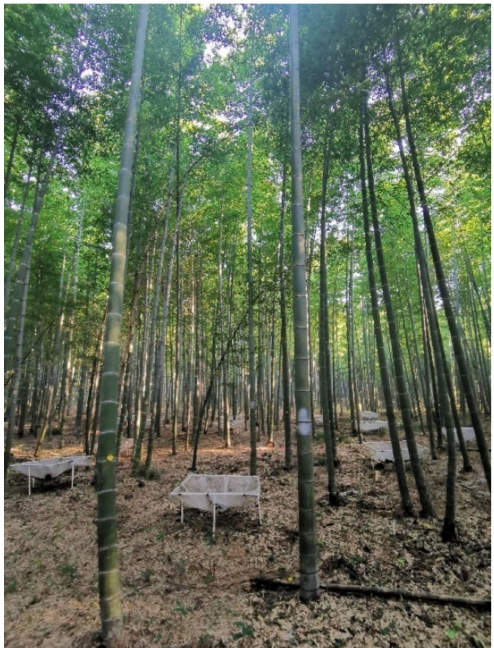
Figure 2. Actual situation of bamboo forest in the sample plot.